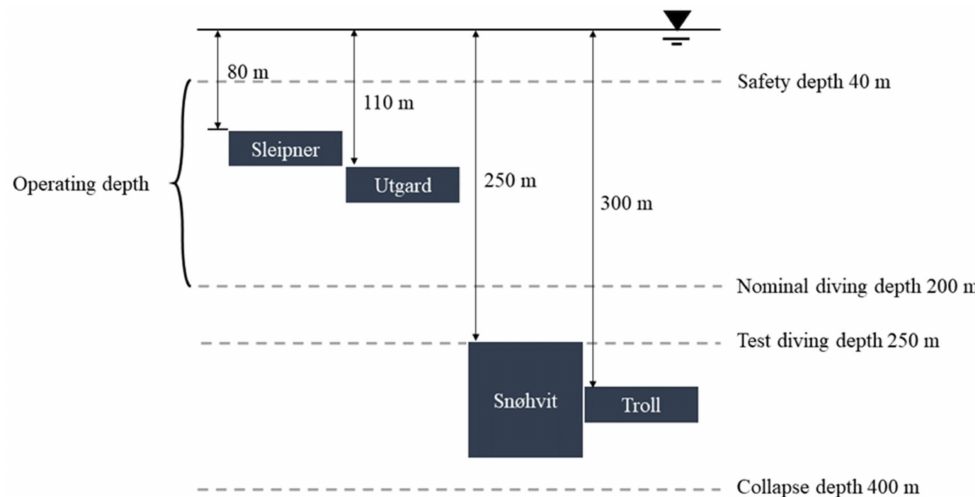
Figure 3. Working depth of the subsea freight